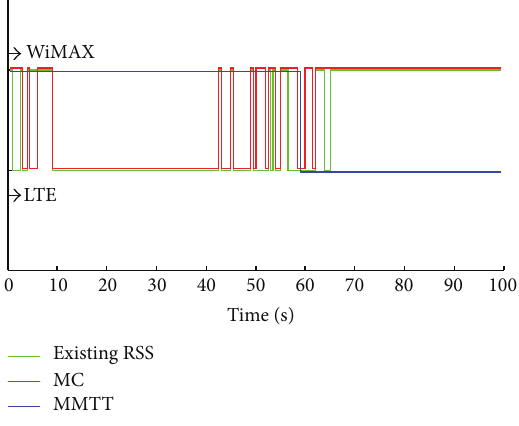
Figure 11: HHO and VHO with FRR3.